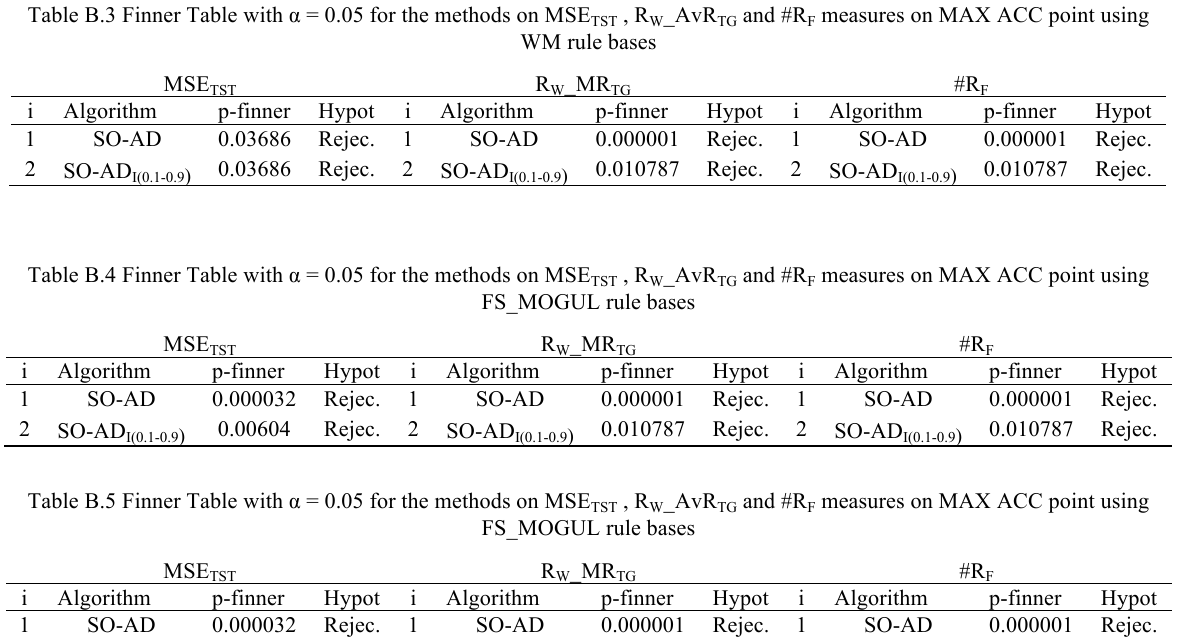
Table B.3 Finner Table with α = 0.05 for the methods on MSE TST , R W _AvR TG and #R F measures on MAX ACC point using